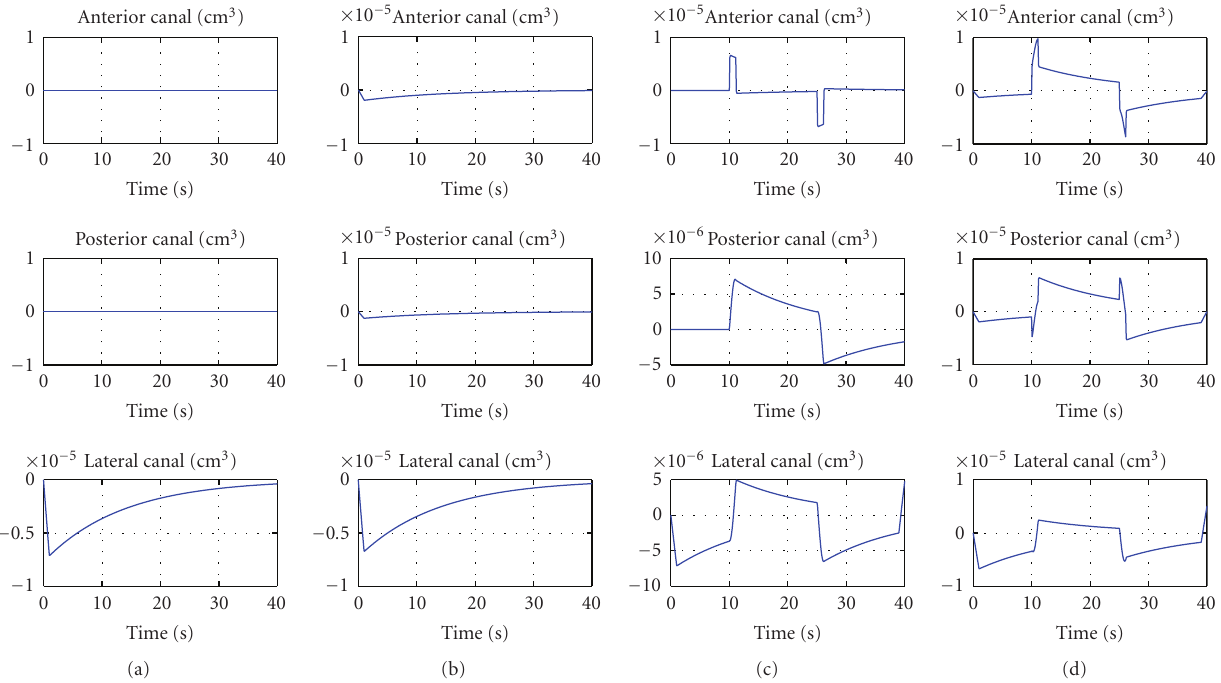
Figure 9: Displacement of the cupula of each canal due to: (a) and (b) rotation movement of the chair, (c) and (d) rotation movement of the chair and of the head. The graphics (a) and (c) correspond to an orthogonal coordinate system R 3 , whereas (b) and (d) correspond to a non-orthogonal coordinate system R 3 . The non-orthogonality of R 3 entails a slight response of the verticals canals. This kind of response might be similar in the case of the existence of coupling terms between the canals due to fluid flow.